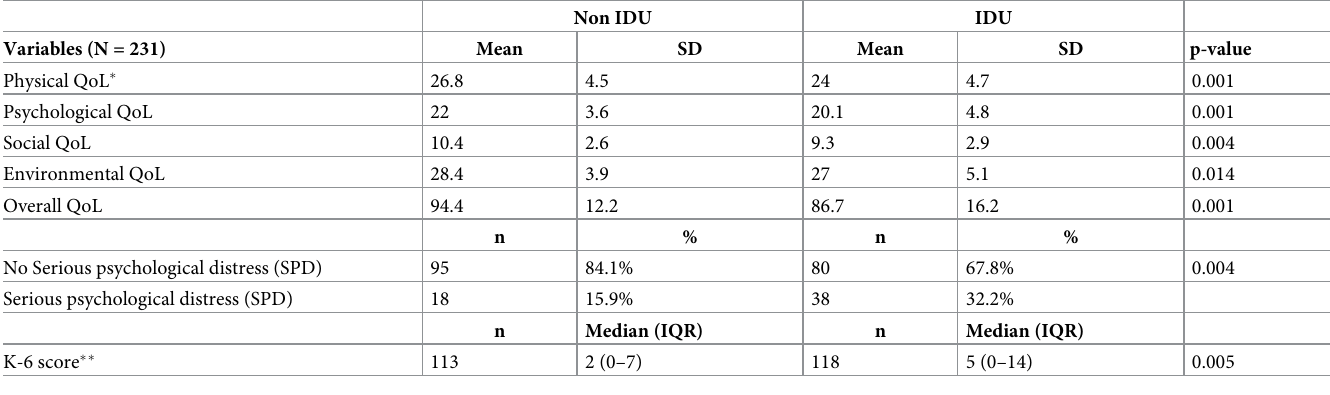
Table 3. Difference in Quality of Life (QoL) and psychological distress among non IDU and